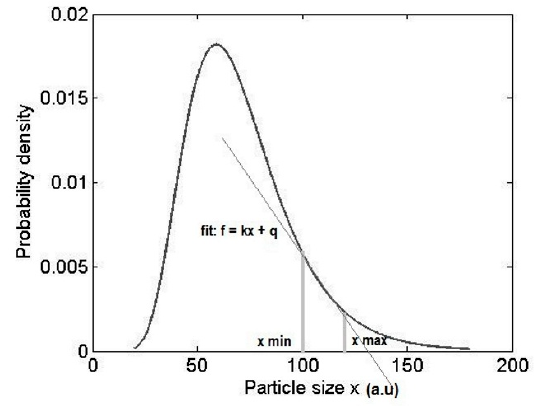
Figure 3. Linear approximation of particle size distribution within a narrow interval of log-normal particle size distribution.